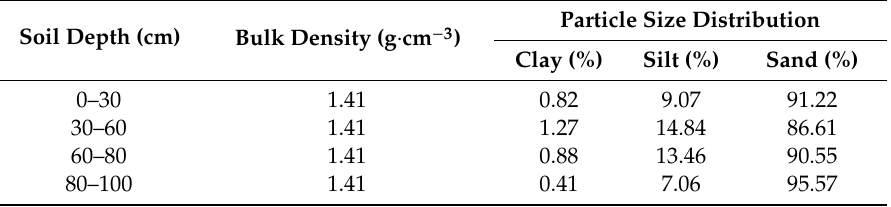
Figure 1. Location of Taigu Water Balance Experimental Station ( a ) Taigu experimental station; ( b ) automatic weather station. Table 1. Properties of soils in micro-lysimeters.